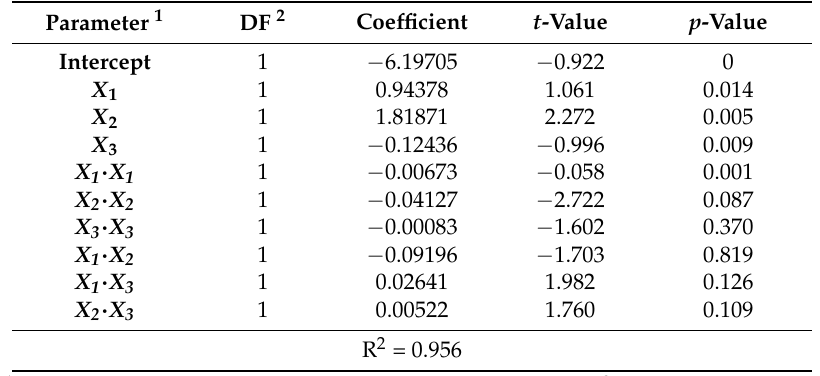
Table 3. The results of estimating regression coefficients of the second order polynomials for C3G contents in the